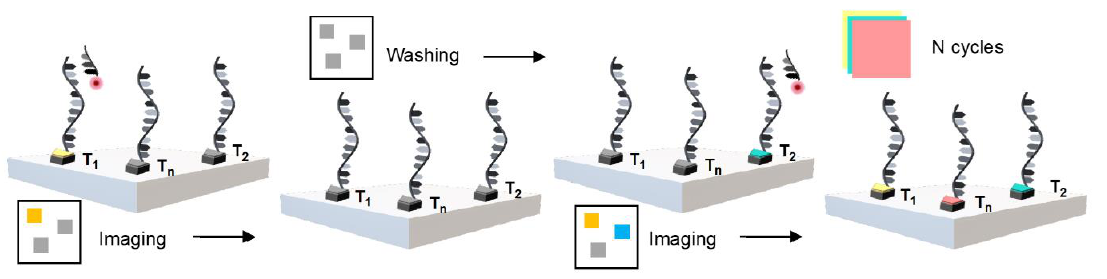
Figure 10. Presentative illustration of Exchange-PAINT.